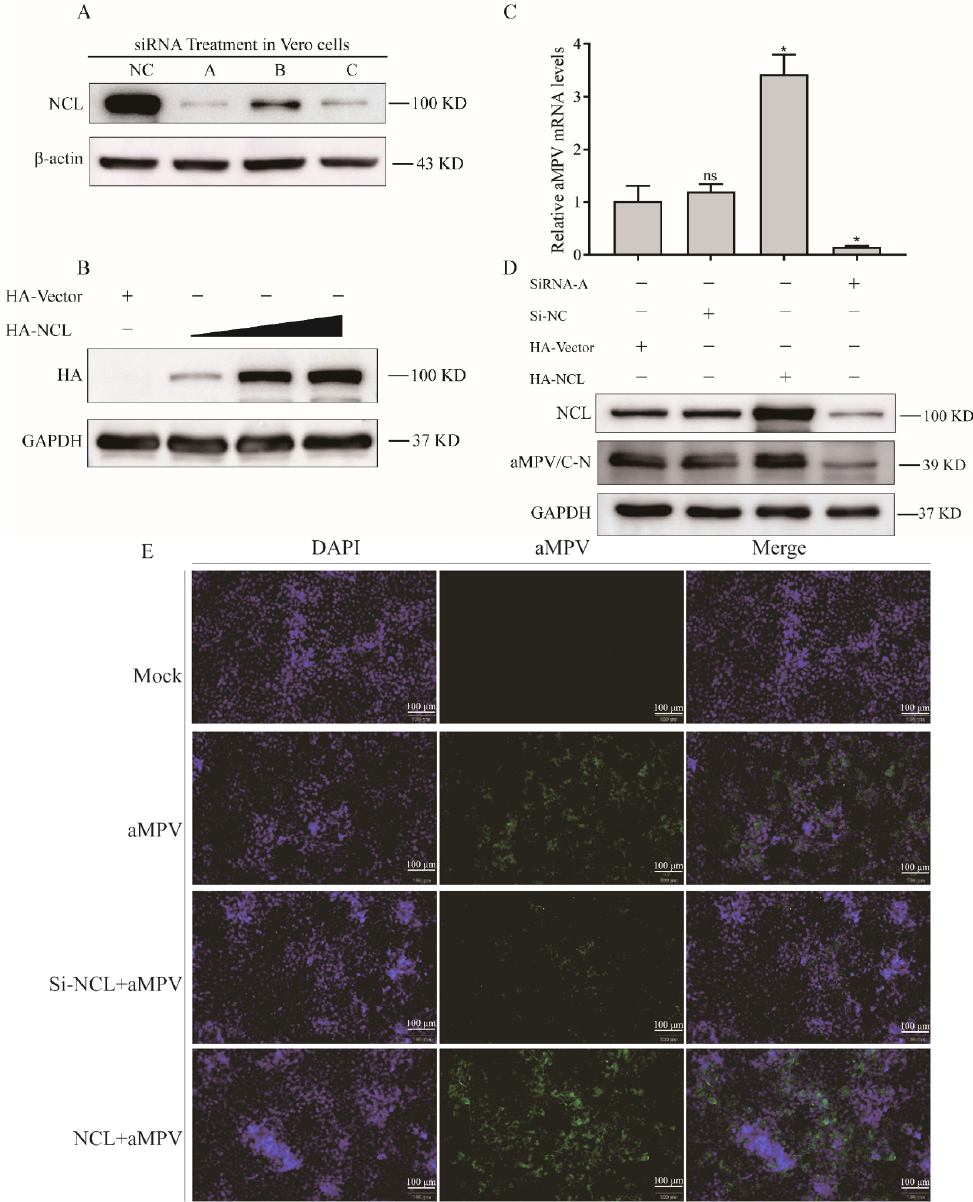
Figure 2. NCL promotes aMPV/C replication. ( A , B ) 20 μ M of NCL − siRNA or increased amounts of pCMV − HA − N − NCL plasmids were transfected or mock − transfected into Vero cells. At 24 h, NCL proteins were detected by western blot. β− actin served as an internal control. ( C ) qRT − PCR was performed to determine the relative aMPV/C RNA level in Vero cells under both knockdown and overexpression of NCL, and western blot * p < 0.05 were considered statistically significant; ns, not significant. ( D ) was used to quantify the viral protein expression level under these conditions. The expression of total GAPDH protein and GAPDH mRNA were utilized as controls. ( E ) Vero cells transfected with NCL − siRNA or CMV − HA − N − NCL plasmids were infected with aMPV/C for 48 h, the cells were then directly observed under an immunofluorescence microscope and a specific antibody to the aMPV/C (green), and nuclei were stained with DAPI (blue).